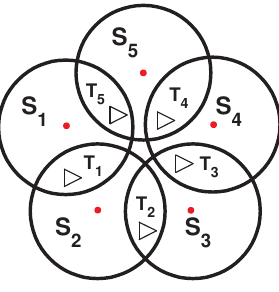
Figure 1. Example topology for sensors and targets.